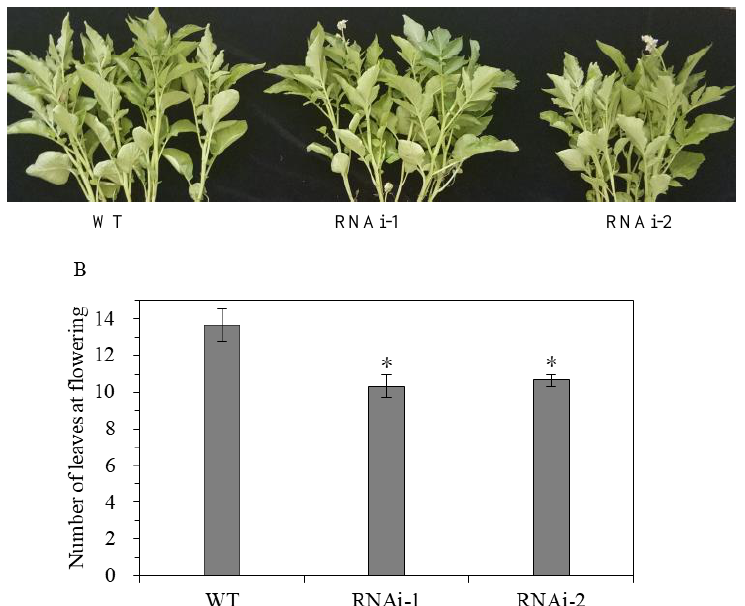
Figure 6. Flowering time ( A ) and the number of leaves at the flowering time ( B ) are significantly affected by StSUT2-RNAi. "*" means the difference is statistically significant between RNAi lines and WT.